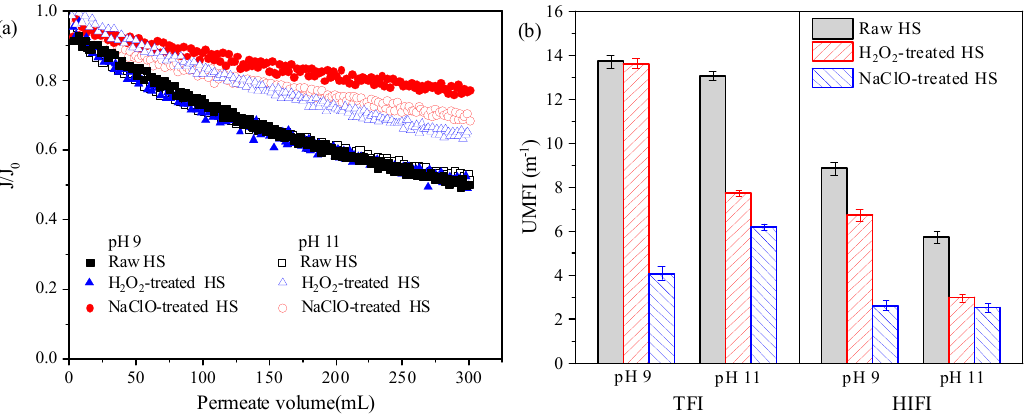
Figure 3. Fouling potential of HS before and after reacting with H 2 O 2 and NaClO: ( a ) Flux decline, ( b ) unified membrane fouling index (UMFI). The ratio of oxidant to dissolved organic carbon (DOC): 13:1; reaction time: 6 h. (TFI: total fouling index, HIFI: hydraulically irreversible fouling index)